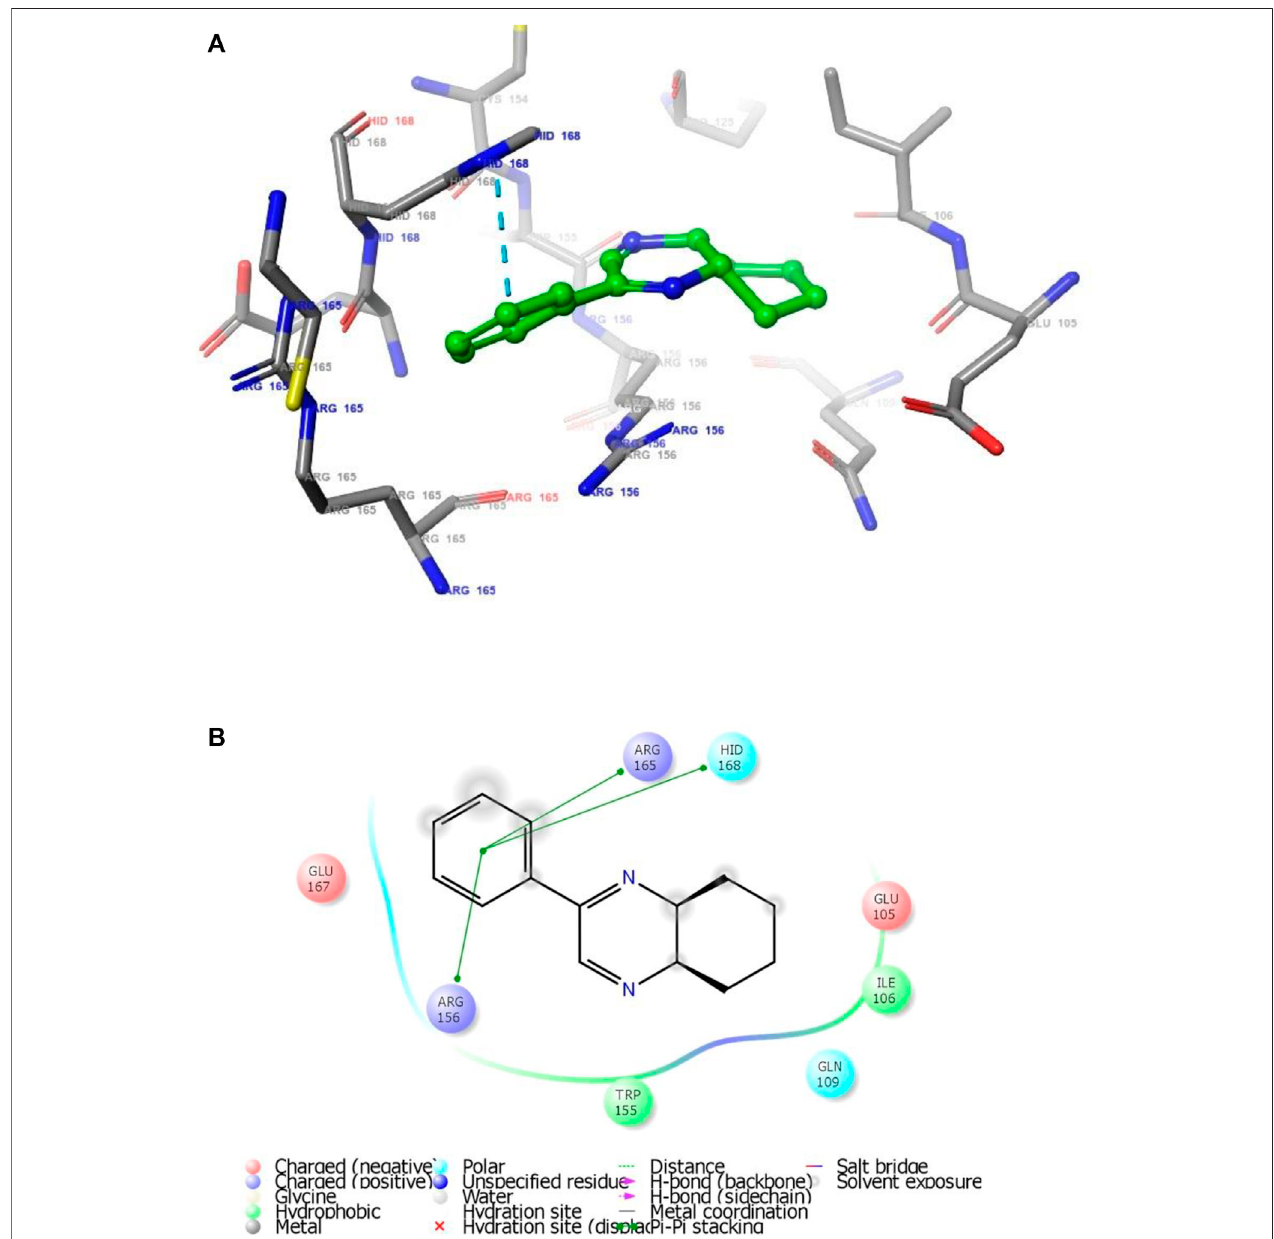
FIGURE2|(A) Thebindingmodeoftheinteractionsbetween 1 with T.cruzi Histidyl-tRNAsynthetase(PDBID:4YPF). (B) Resultsofthevalidationof 1 insidethe T. cruzi histidyl-tRNA synthetase active sites.